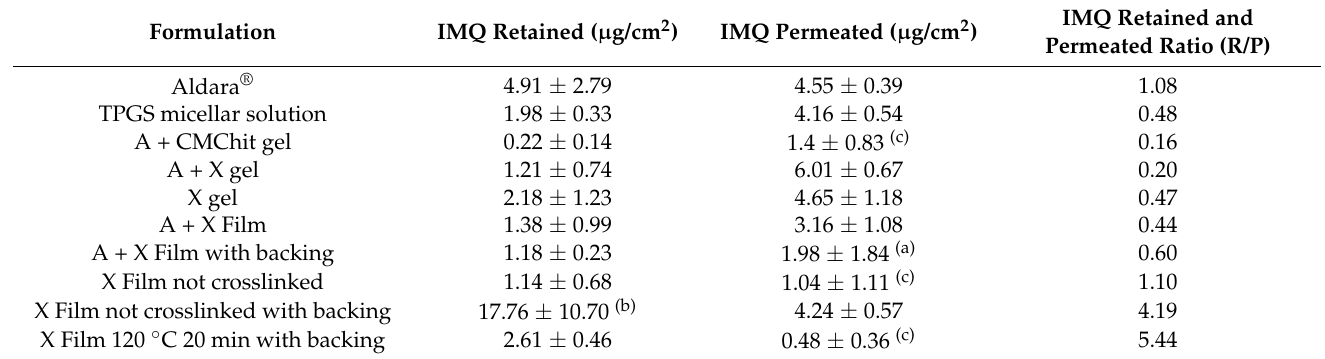
Table 2. IMQ retained and permeated across porcine esophageal epithelium from topical formulations (mean ±